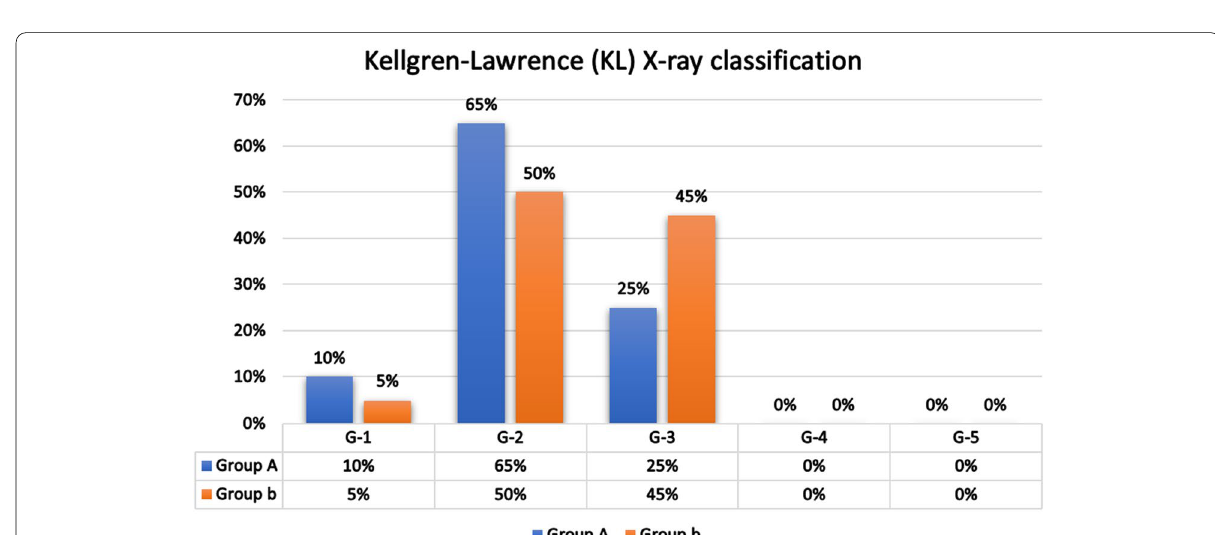
Fig. 11 Preoperative Kellgren–Lawrence scale of both